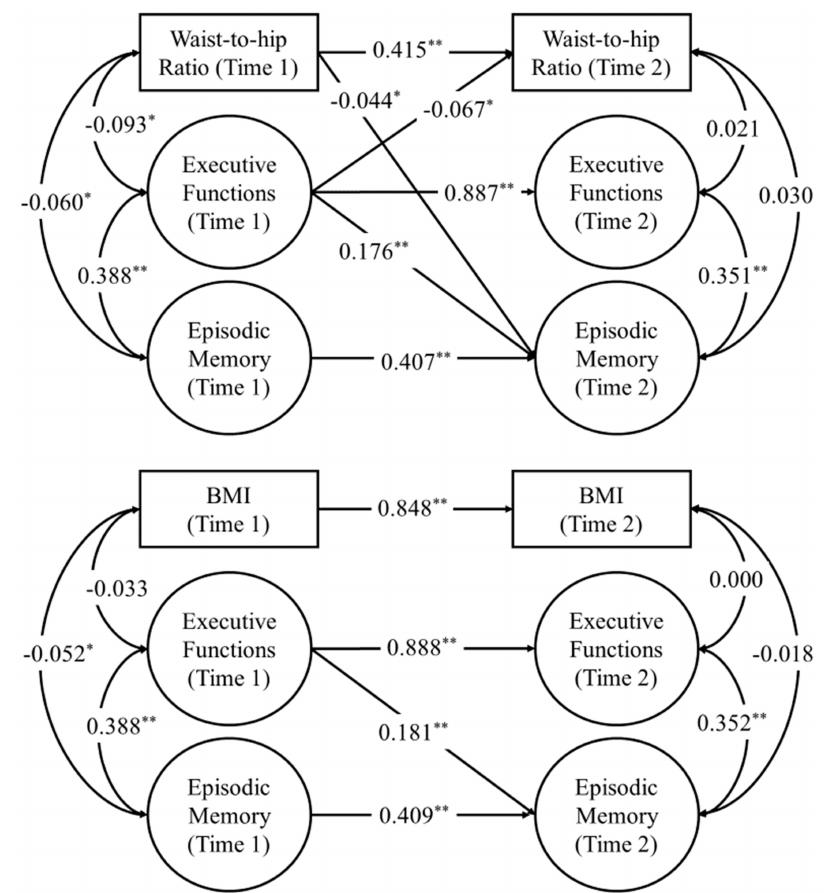
Figure 1. Cross − lagged panel models after controlling for age, sex, education attainment, and household income. For the purposes of clarity, factor indicators, autocorrelations among indicator residuals, and control variables are not shown, and only significant cross − lagged paths are displayed. The analyses were conducted while holding the optimal equality constraints (partial scalar invariance). The numbers are standardized coe ffi cient estimates. * p < 0.05 ** p <